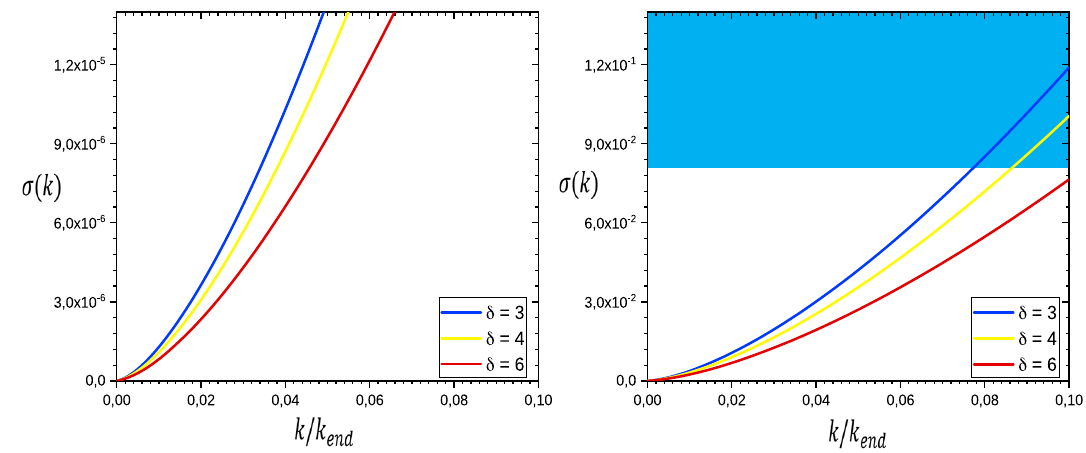
Fig. 4 The mass variance σ( k ) as a function of dimensionless wavenumber k / k end , for δ = 3 (blue-line), δ = 4 (yellow-line), δ = 6 √ (red-line), Φ (cid:4) M p / 12 π, g = 10 − 3 , m = 10 − 6 M p and q = 6600.